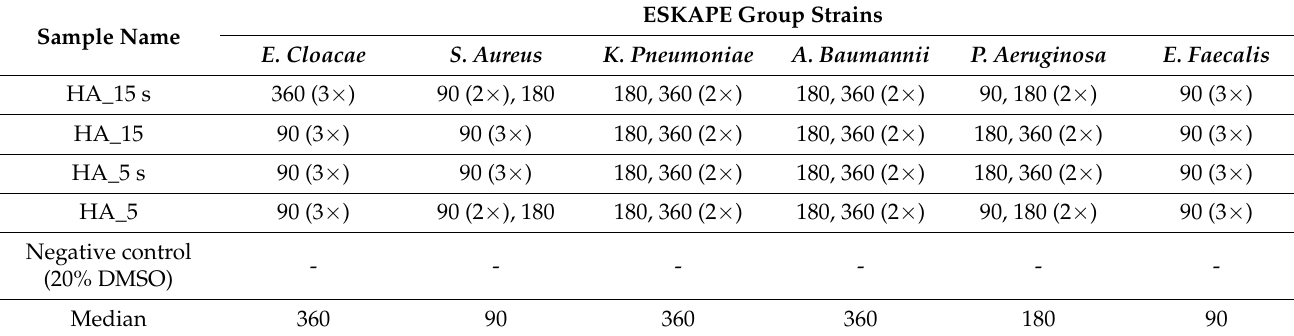
Table 8. Mean minimum inhibitory concentration (MIC) values ( µ g/mL).